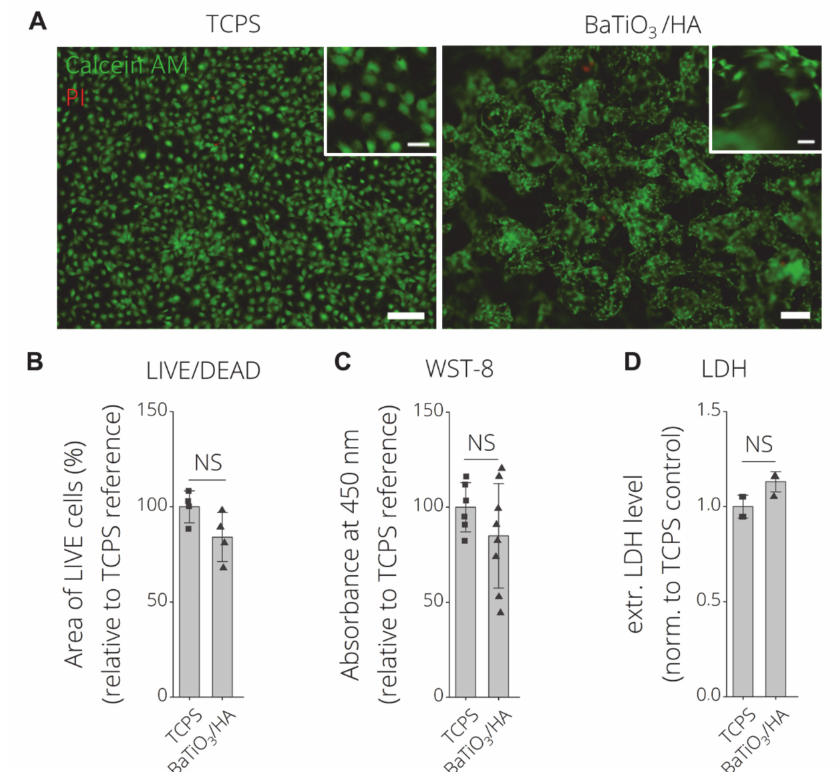
Figure 10. Direct in-vitro cytocompatibility test of MC3T3-E1 cells after 24 h of incubation on BaTiO 3 / HA. ( A ) LIVE / DEAD Images of Calcein AM (green, live) and propidium Iodide (red, dead) stained MC3T3-E1 cells after 24 h of direct incubation on TCPS and BaTiO 3 / HA sca ff olds. Scale bars: 200 µ m, 50 µ m (detail). ( B ) Quantification of LIVE / DEAD data as the area of live cells (%) per image (n > 4 biological replicates, n = 3 images) normalized to tissue culture polystyrene reference substrates. ( C ) Indirect